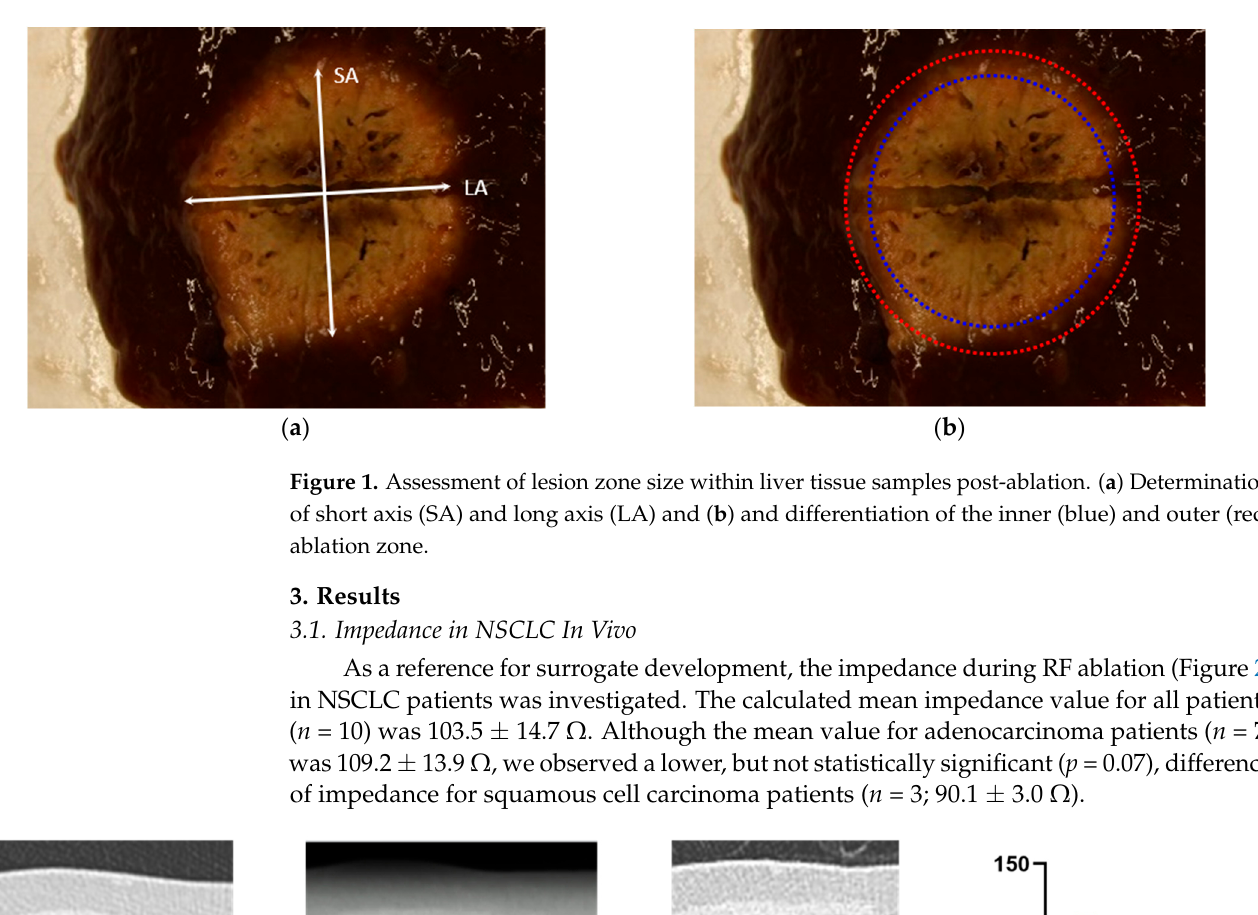
Figure 1. Assessment of lesion zone size within liver tissue samples post-ablation. ( a ) Determination of short axis (SA) and long axis (LA) and ( b ) and differentiation of the inner (blue) and outer (red) ablation zone.